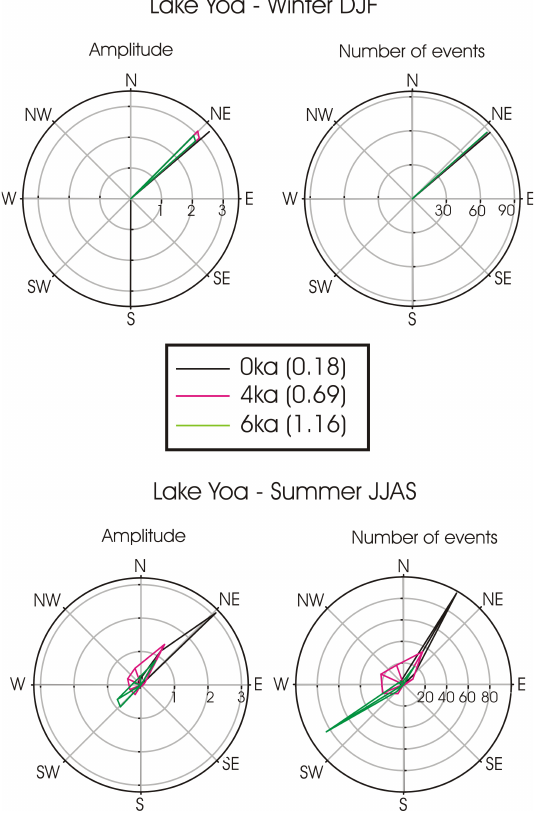
Fig. 5. Number of wind events and mean wind speed as a func- tion of wind direction diagnosed over Lake YOA region (17.5 ◦ E– 22.5 ◦ E, 17 ◦ N–22 ◦ N averaged) from the daily model outputs for (a) winter time (DJF) and (b) summer time (JJAS) and the 3 cli- mate periods considered in this study: 6ka, 4ka and present. Units for the wind amplitude: ms − 1 .